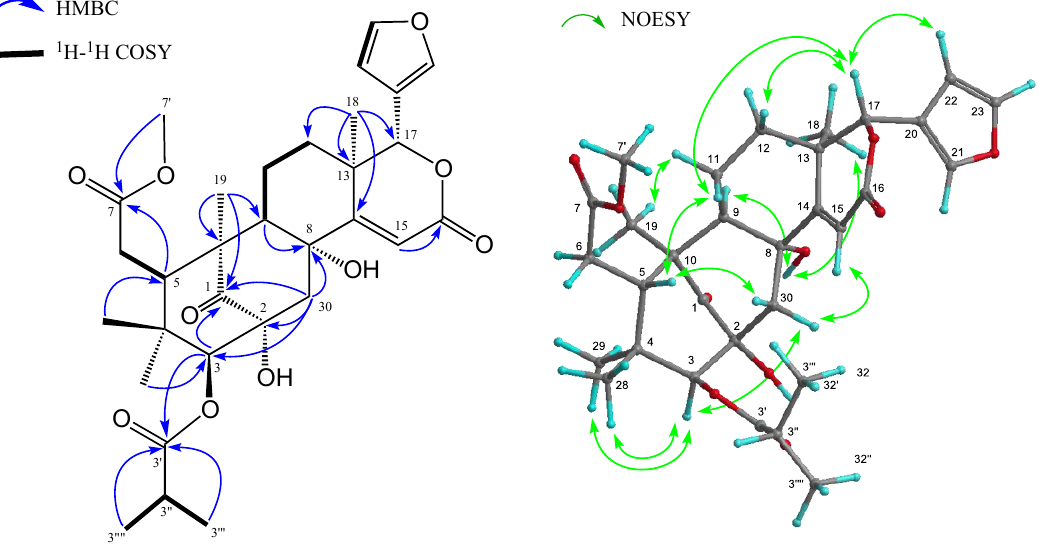
Figure 2. Key HMBC, COSY and NOESY correlations for carapanolide T ( 1 ).